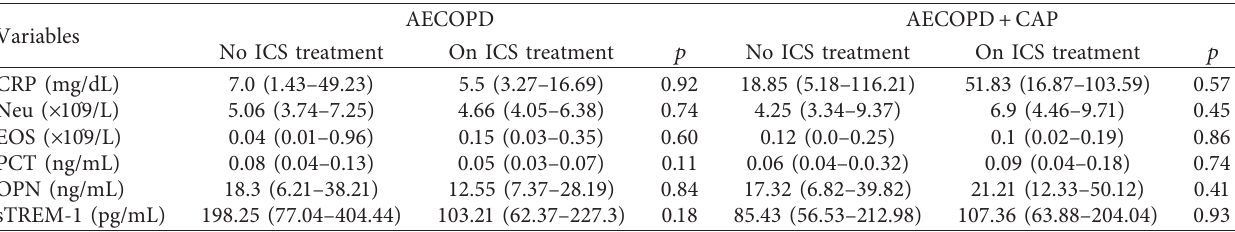
Table 6: The levels of CRP, PCT, Neu, EOS, sTREM-1, and OPN in patients with AECOPD/AECOPD +CAP according to the current use of ICS.